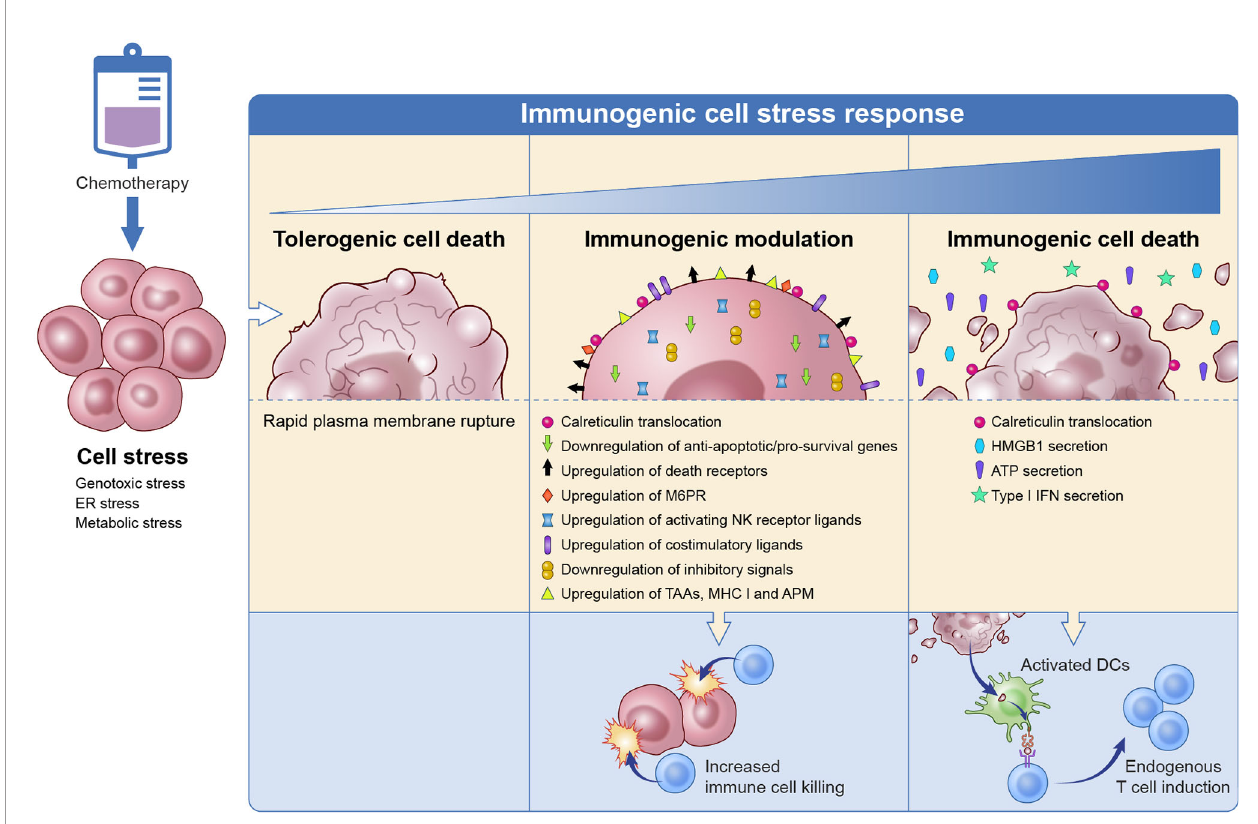
FIGURE 1 | Chemotherapy induces immunogenic cell stress resulting in a spectrum of downstream events from tolerogenic cell death to immune modulation to immunogenic cell death. Tolerogenic cell death induced by chemotherapy is a non-in fl ammatory cell death that involves the rapid rupture of the plasma membrane and does not trigger immune cells. On the other end of the spectrum, chemotherapy can cause immunogenic cell death that results in the release of DAMPs that promote immune cell phagocytosis, tumor antigen processing, and antigen presentation to T cells. Tumor cells that were not eradicated with chemotherapy undergo immunogenic modulation wherein the tumor surface phenotype is altered to promote T cell targeting of the tumor cell. DAMP, damage-associated molecular patterns; TAA, tumor-associated antigen; MHC, major histocompatibility complex; APM, antigen processing machinery; M6PR, mannose-6-phosphate receptor; NK, natural killer; HMGB1, high mobility group box 1; ATP, adenosine triphosphate; IFN, interferon. Adapted from Ref